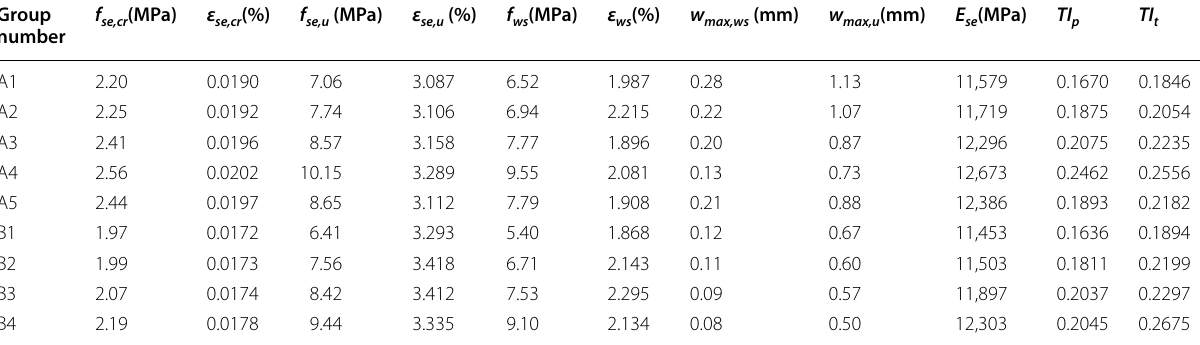
Table 4 Test results of HSSSWR-reinforced ECC